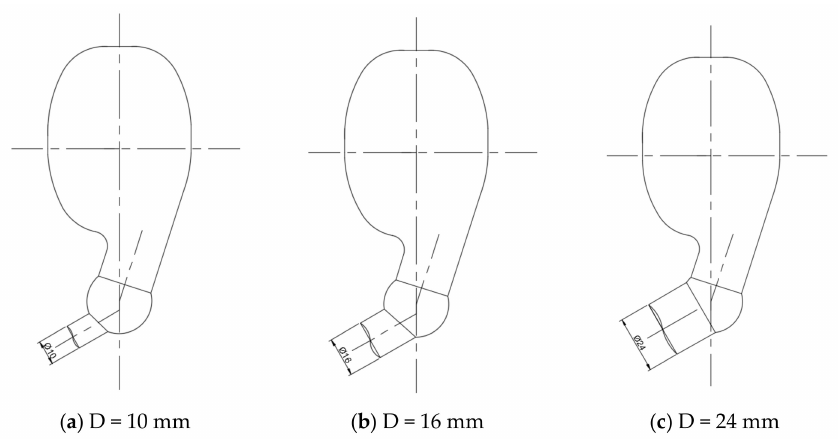
Figure 8. Di ff erent schemes of pre-combustion chamber (PCC) nozzle